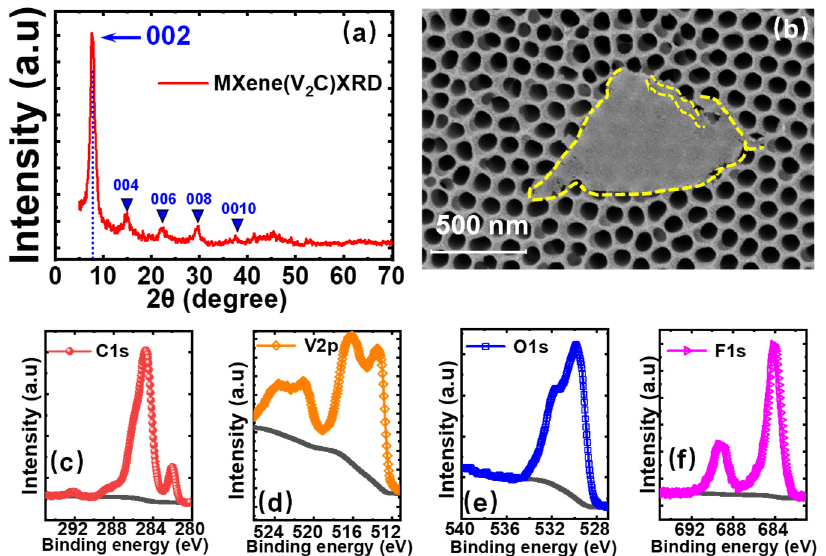
Figure 1. Material characterization of V 2 C MXene. ( a ) XRD pattern of V 2 C powders used in this work. ( b ) SEM image of prepared V 2 C powders on the substrate of porous alumina. ( c – f ) XPS spectra of V 2 C MXene for ( c ) V2p ( d ) C1s ( e ) O1s, and ( f ) F1s.